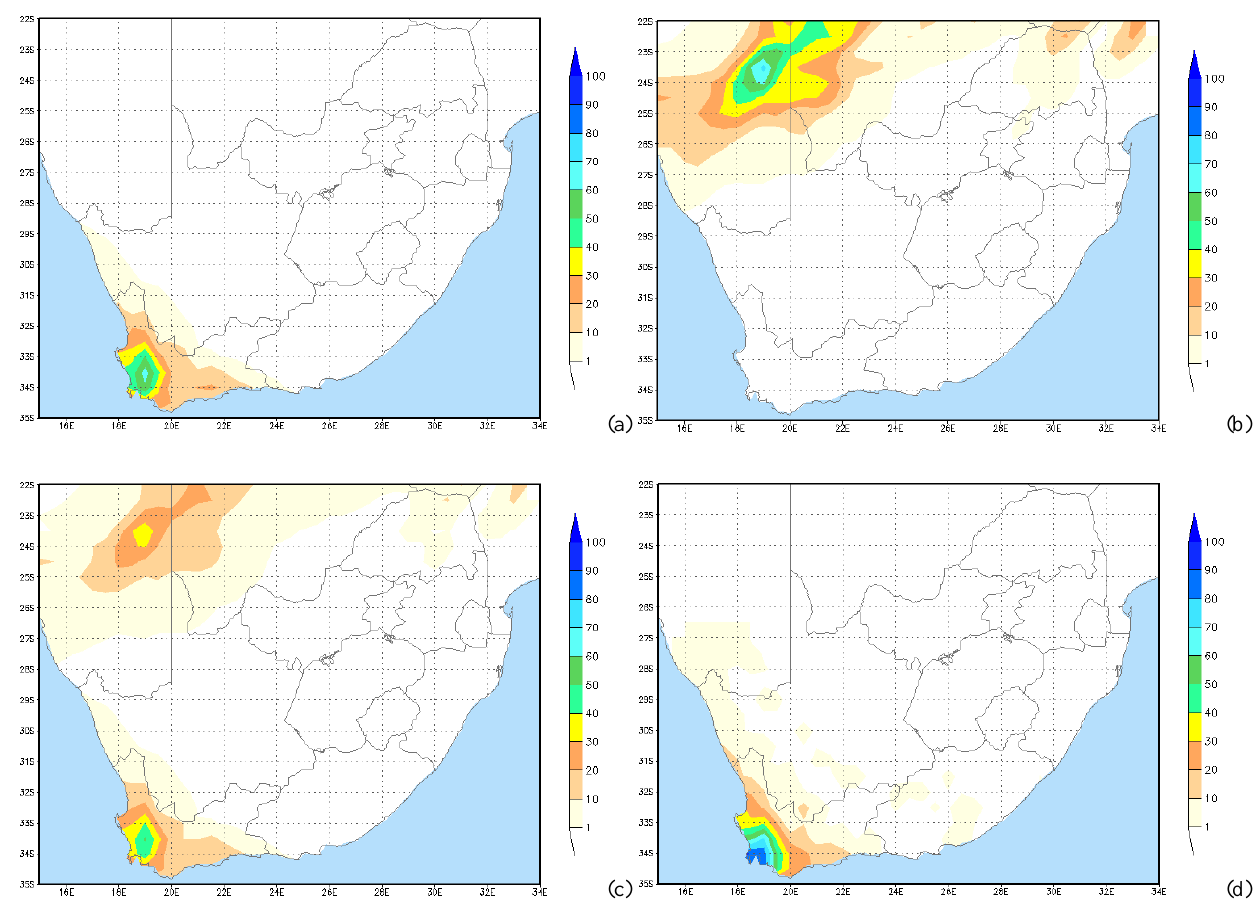
Fig. 17. Unified Model stratiform precipitation total for 24h (a) , Hydroestimator precipitation total for 24h (b) , the combined product from HE and UM for 24h (c) and the total rainfall as measured by the rain gauges (d) for 12 July 2009.